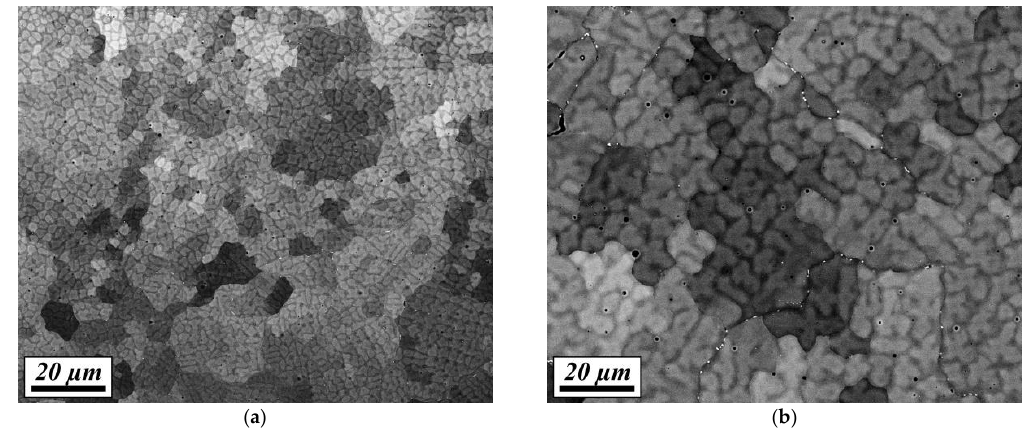
Figure 3. SEM-BSE images: ( a ) SEBM Specimen A; and ( b ) SEBM Specimen B.